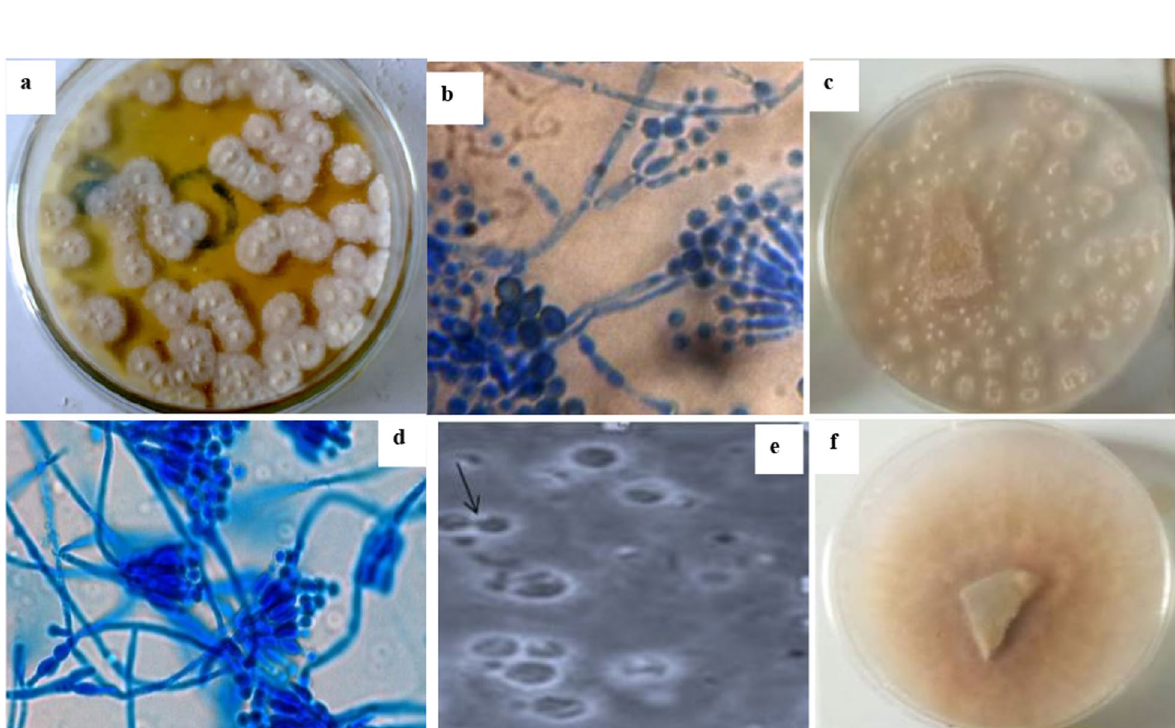
Fig. 1 Aspergillus candidus and Aspergillus sydowii a , c wild-type strains on PDA plates b , d in microscopy e Fusant-06 in light microcopy 400 X f Fusant-06 regenerated on PDA for 72